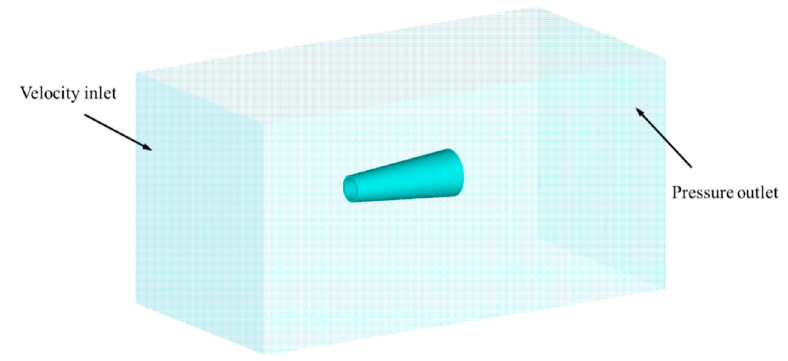
Figure 2. Numerical model and boundaries for simulating the drag force.